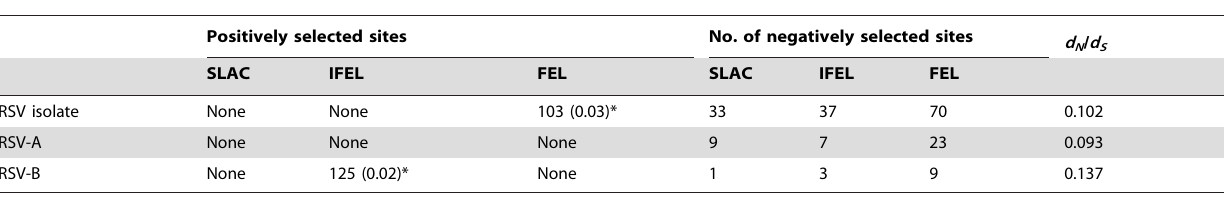
Table 4. Selection sites detected in RSV fusion protein genes.